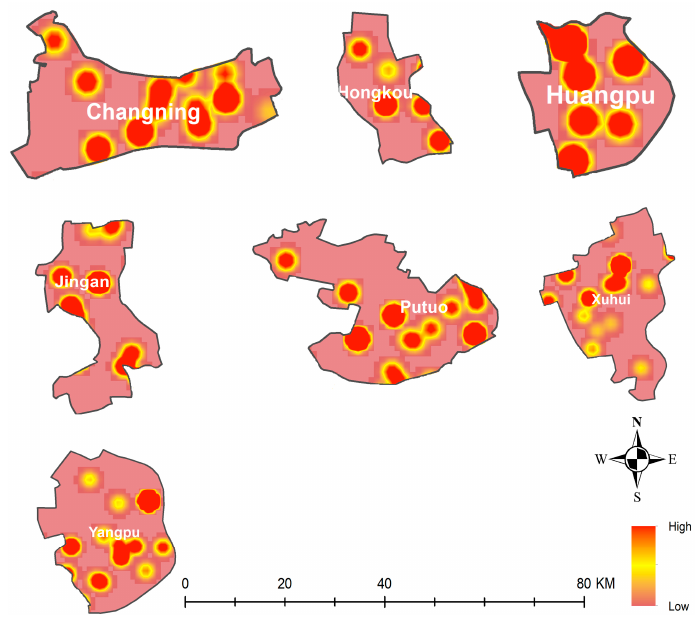
Figure 8. Check-in density in the districts.